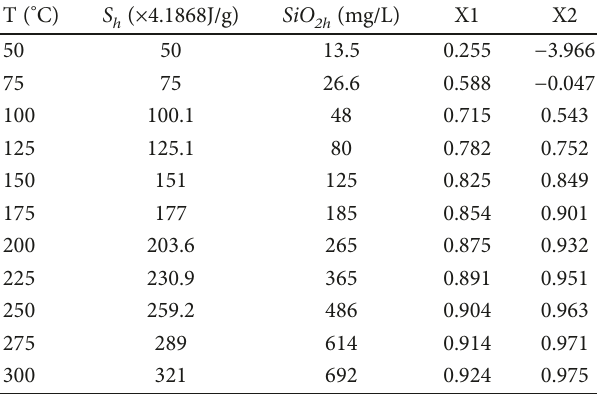
Table 3: Relationship between the hot water temperature, enthalpy, SiO content, and ratio of cold water (X). 2